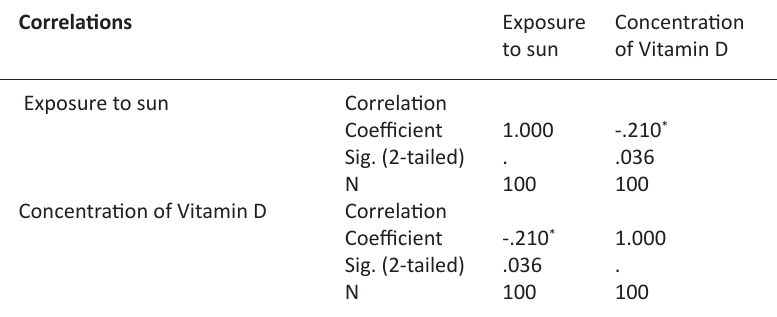
Concentration of Vitamin D Correlation